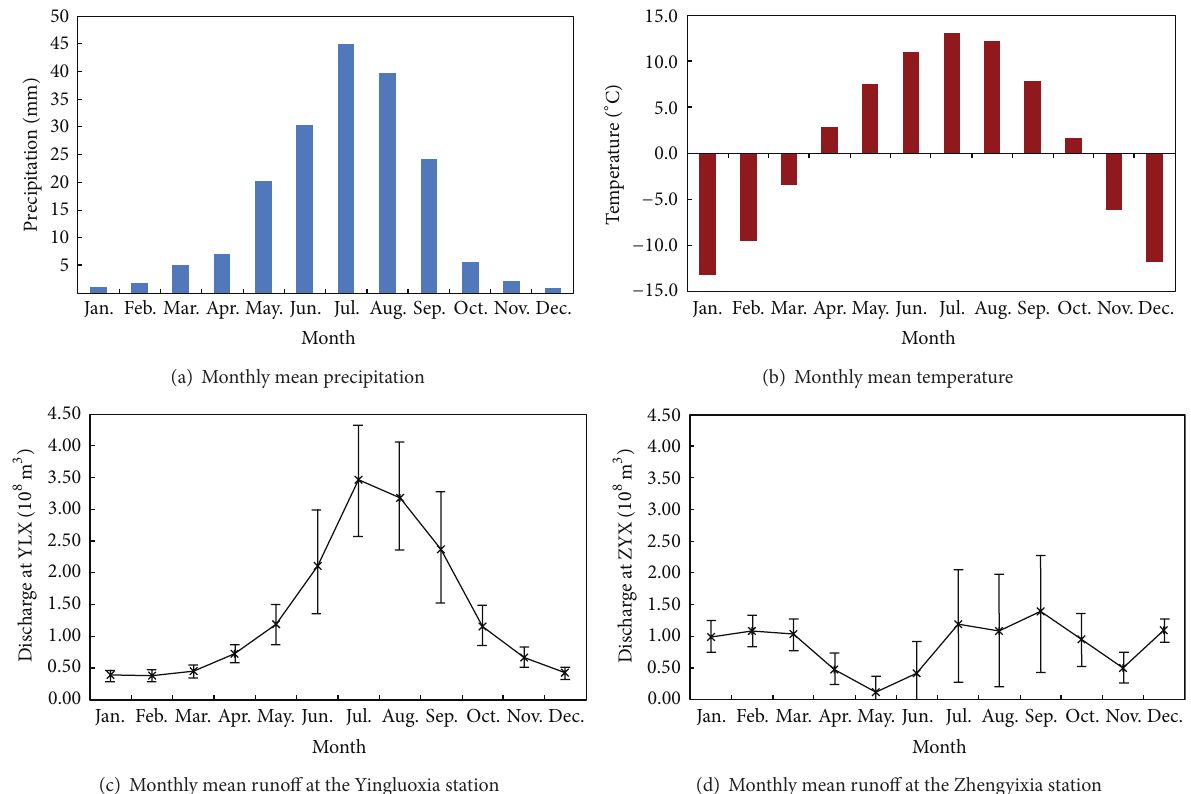
Figure 2: Meteorological and hydrological conditions in the Heihe River Basin (1957–2010). ∗ Bars indicate standard deviation of monthly runoff during